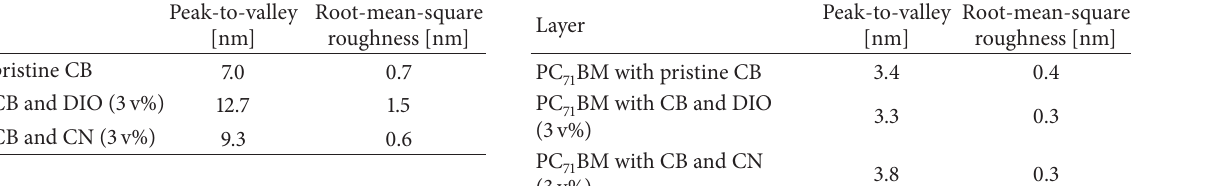
BM thin films 71